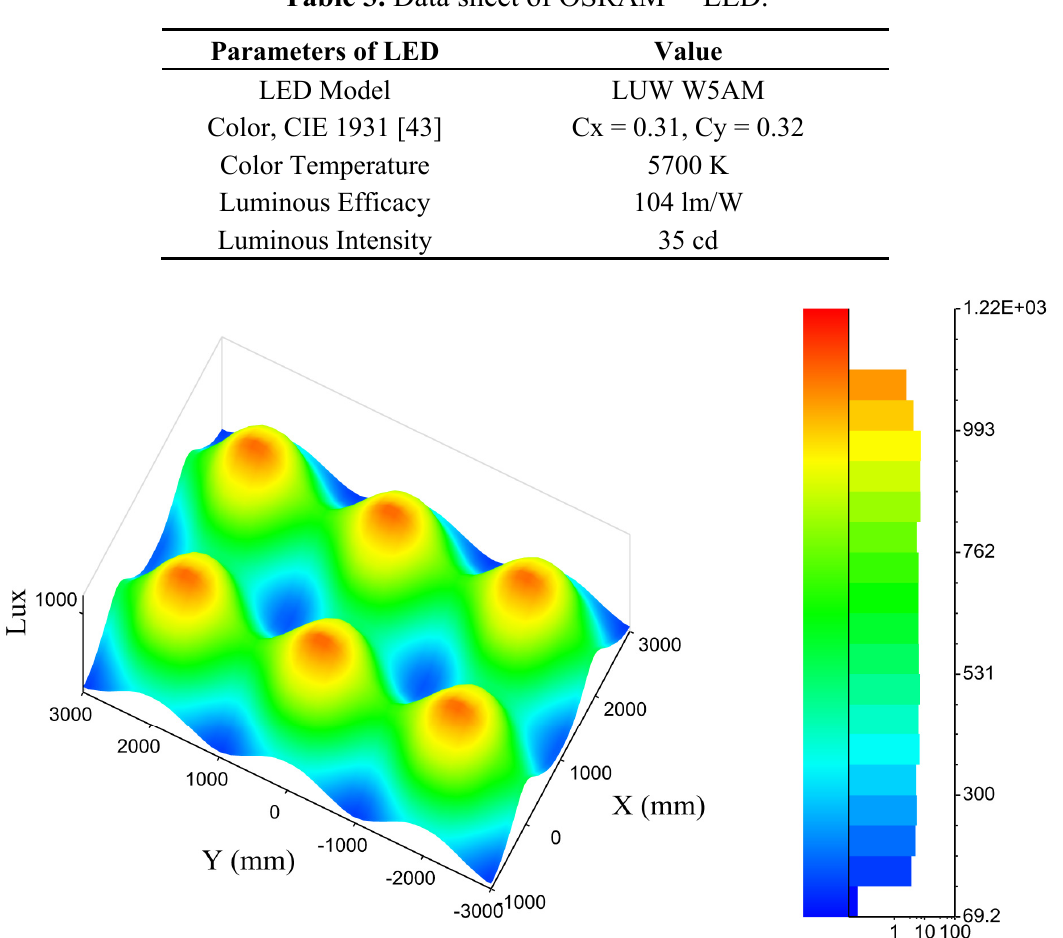
Figure 10. Illuminance distribution on the working plane by LED